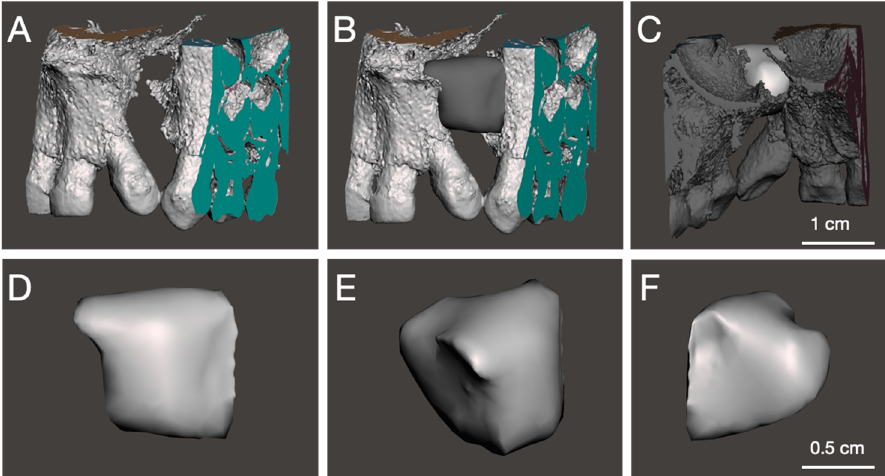
Figure 7. Example of design of a part from the CBCT seen in the previous figure. Initial situation ( A ) then with the part filling the critical defect in front ( B ) and posterior ( C ) view. Front ( D ), anterior ( E ), and posterior ( F ) views of the part.